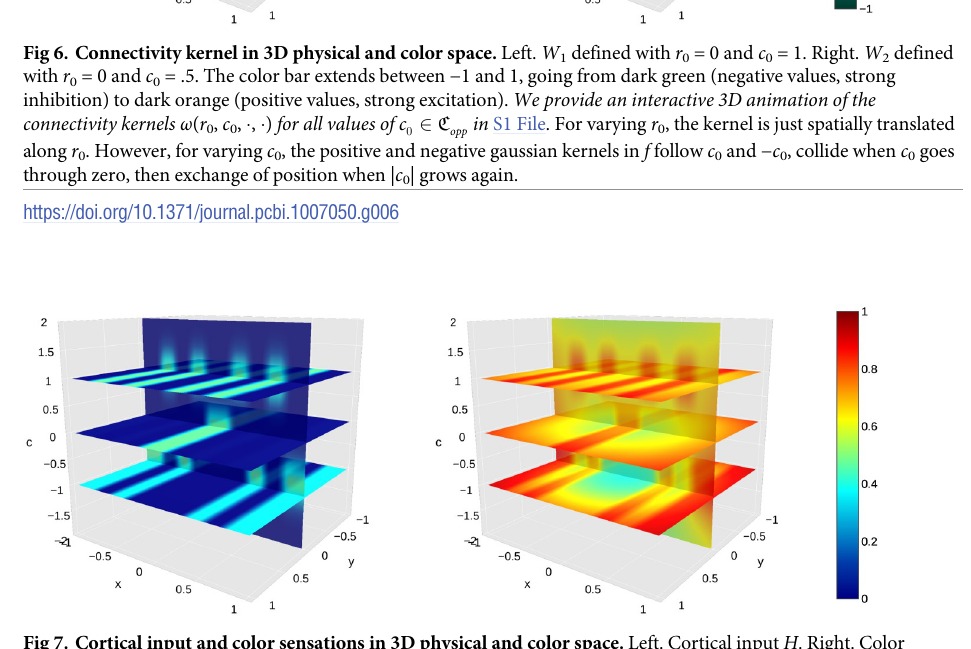
Fig 7. Cortical input and color sensations in 3D physical and color space. Left. Cortical input H . Right. Color sensations a 1 . In both subfigures, the color bar extends between 0 and 1, and is set so that small variations are easily seen. We provide an interactive 3D animation of the evolving activities a ( � , � , t ) along the iterations of the fixed point algorithm in S2 File. The convergence is quite fast and 15 iterations are sufficient.